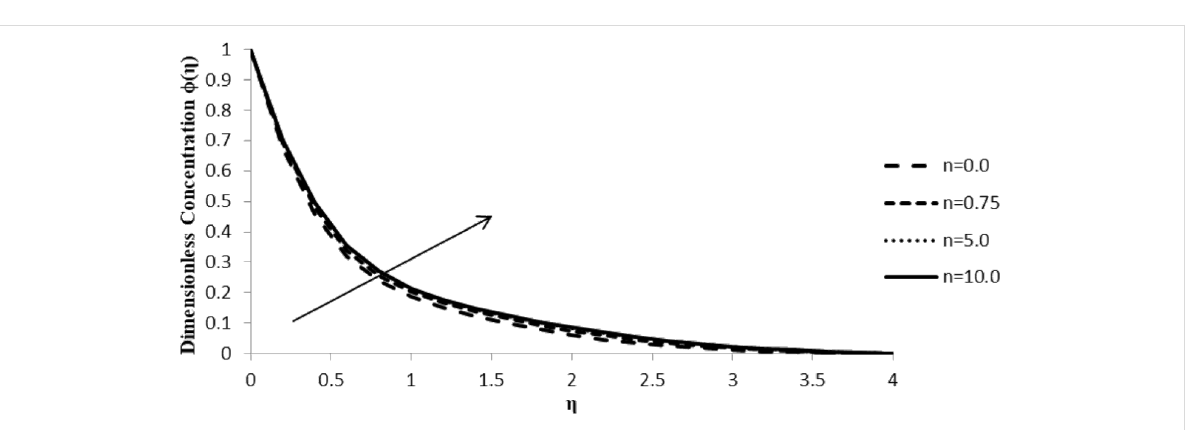
Figure 7: Influence of the stretching parameter n on the concentration distribution ϕ ( η ) when ξ = 1.0, M = Q = 0.0, Pr = 2.0, Nb = Nt = 0.5, Le = 5.0, and F w = 0.2 (due to the boundary condition, the value of ξ is